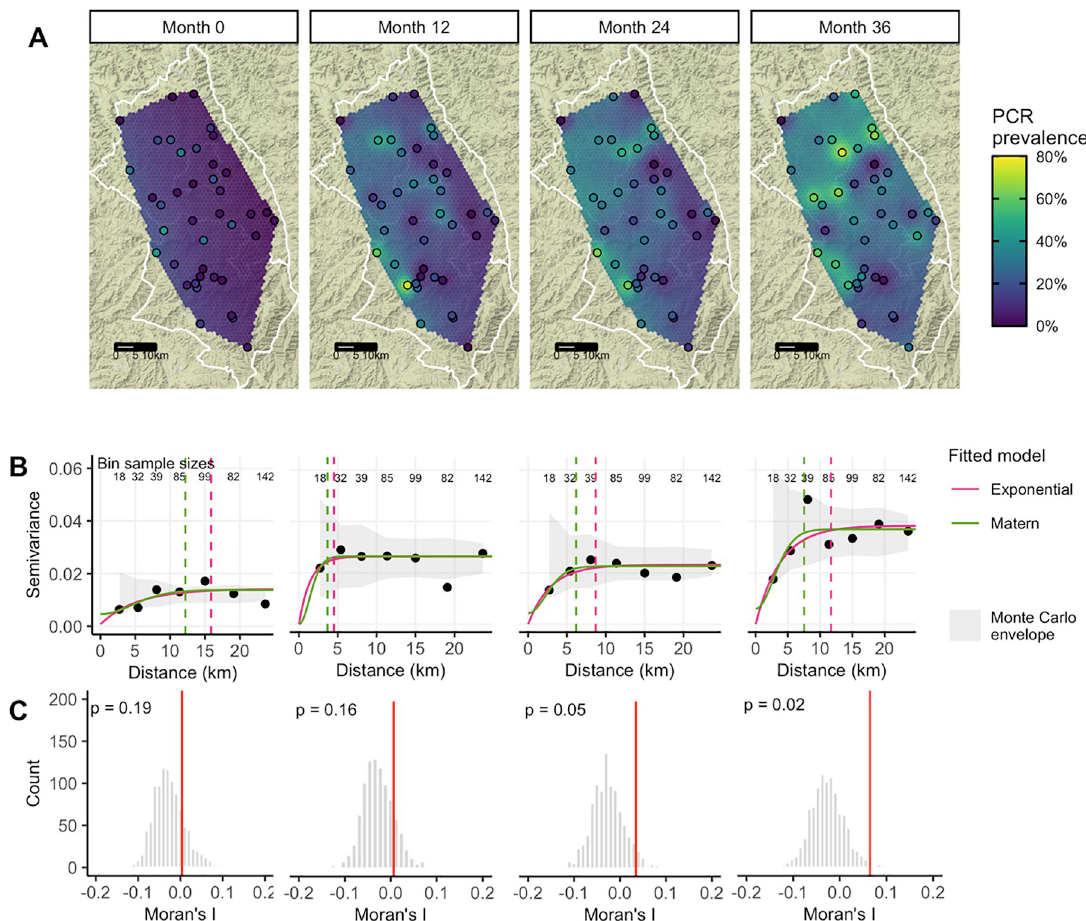
Fig 2. Predicted surface (A), variograms (B), and Moran’s I (C) for PCR-confirmed ocular C . trachomatis infection prevalence among 0–5-year-olds at each study month. Maps display prevalence for 40 study communities at each follow-up visit, spatially interpolated over the convex hull using kriging. Variograms capture similarity between community-level prevalence measurements as a function of distance between community pairs (in km), with smaller semivariance values representing increased similarity. Exponential (magenta) and Mate´rn (green) models were fit to each empirical variogram, and the effective range (dashed vertical line) is defined as the distance at which the fitted model reaches 95% of the sill. The Monte Carlo envelope (gray shading) displays pointwise 95% coverage of 1000 permutations, representing a null distribution. Moran’s I was calculated over 1000 permutations (gray bars, with observed value represented by red line), and a permutation-based p-value was calculated. The base map layer for panel A in this figure was downloaded from Stamen Maps (“Terrain”) and is available under the CC BY 3.0